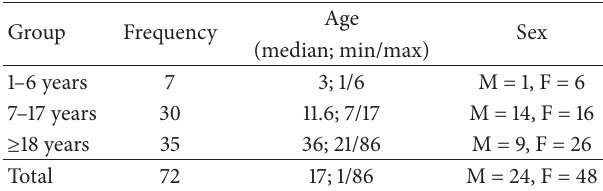
Table 1: Characteristics of the sample ( 𝑛 = 72 ).